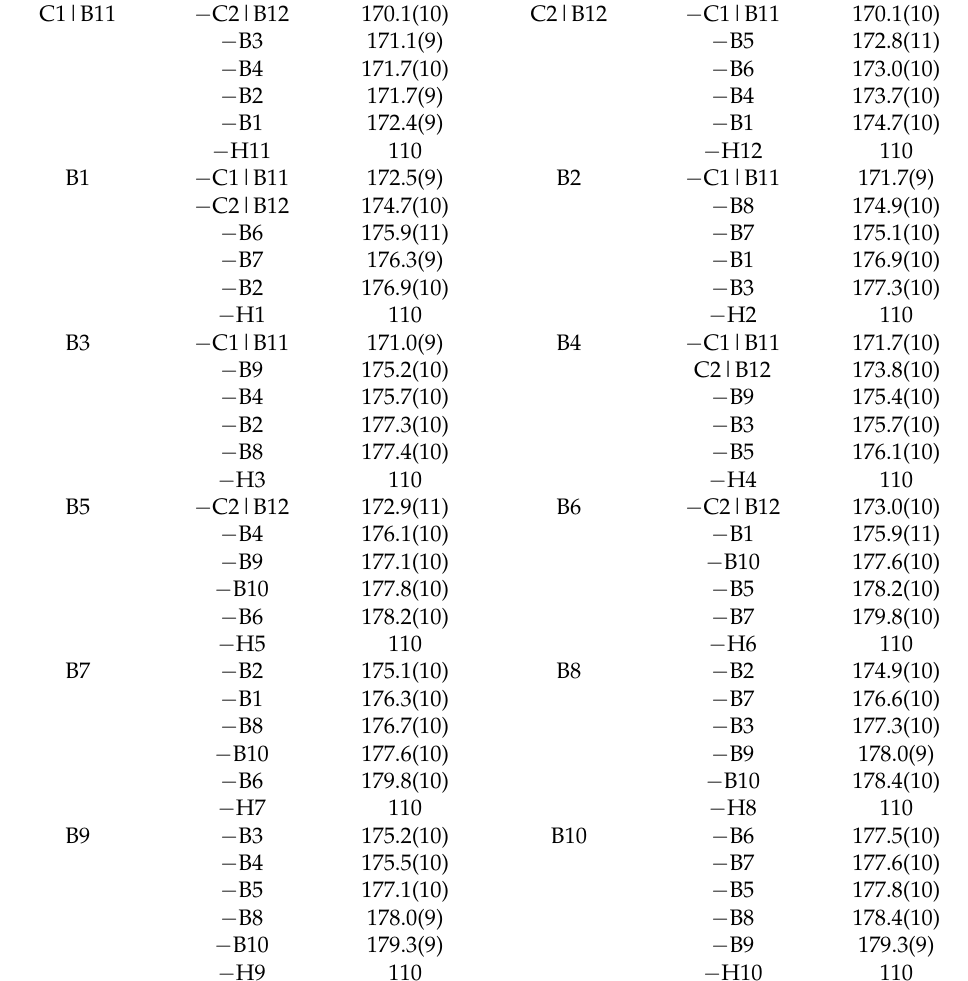
Table 3. Selected intramolecular distances ( d /pm) within the [CB 11 H 12 ] − anion in Tl[CB 11 H 12 ].